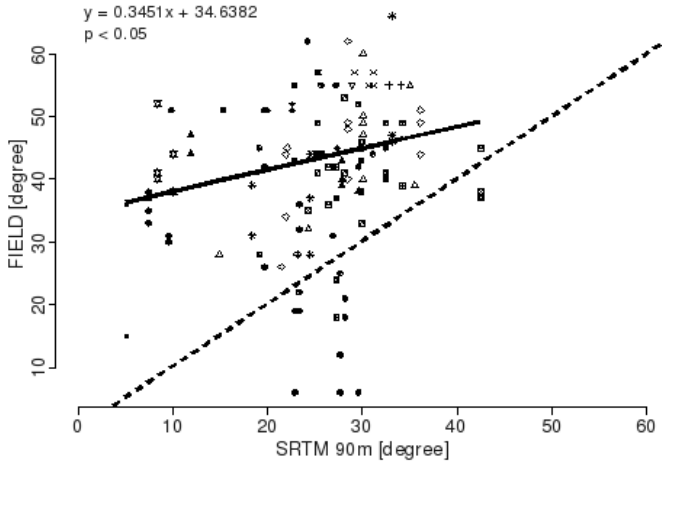
Figure 8. Correlation between slope data from SRTM 90m DEM and field measurements. Different symbols denote data collected along different transects (continuous thick line is the regression